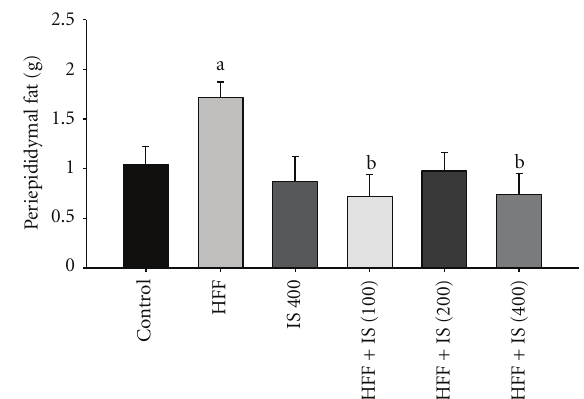
Figure 3: Periepididymal fat in mice fed control diet, or HFF and/or IS for 8 weeks; a: significant di ff erence compared to control; b: significant di ff erence compared to HFF, P < 0 . 05 (one-way ANOVA, Tukey’s post hoc